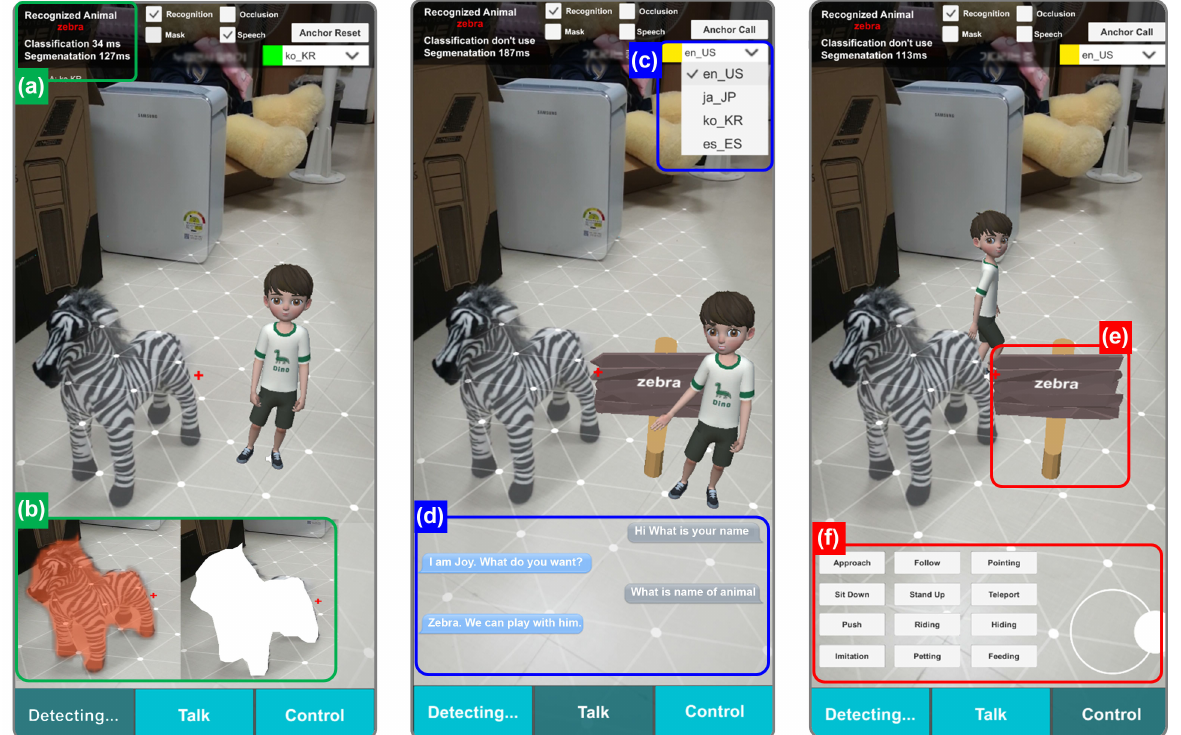
Figure 7. Overview of our multimodal mobile AR system. ( a ) Recognizing real objects; ( b ) displaying the segmentation mask and placing the silhouette mesh; ( c ) supporting multi-language; ( d ) Voice chat between a user and a virtual human based on knowledge database [3]; ( e ) Placement of persistent anchor based on spatial mapping [3]; and ( f ) realistic interactions with real animal dolls using the silhouette